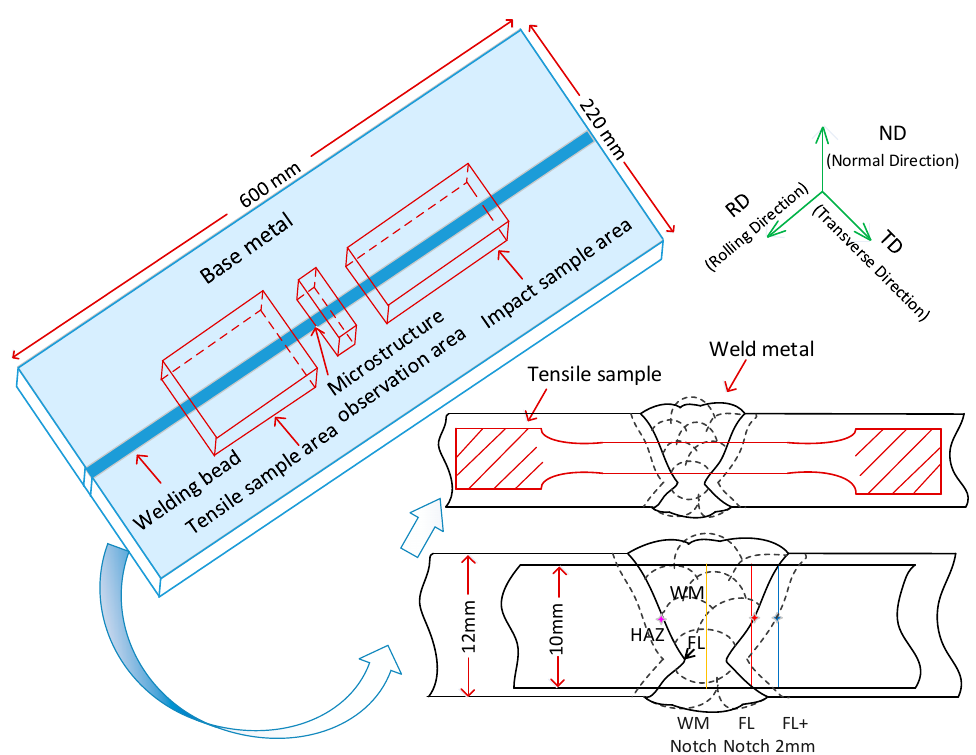
Figure 1. Schematic diagram of sampling location, welding groove, locations of partial Charpy V-notch (indicated by the yellow, red, and blue solid lines) and microstructure characterization locations (indicated by the red, blue and pink four-pointed star).